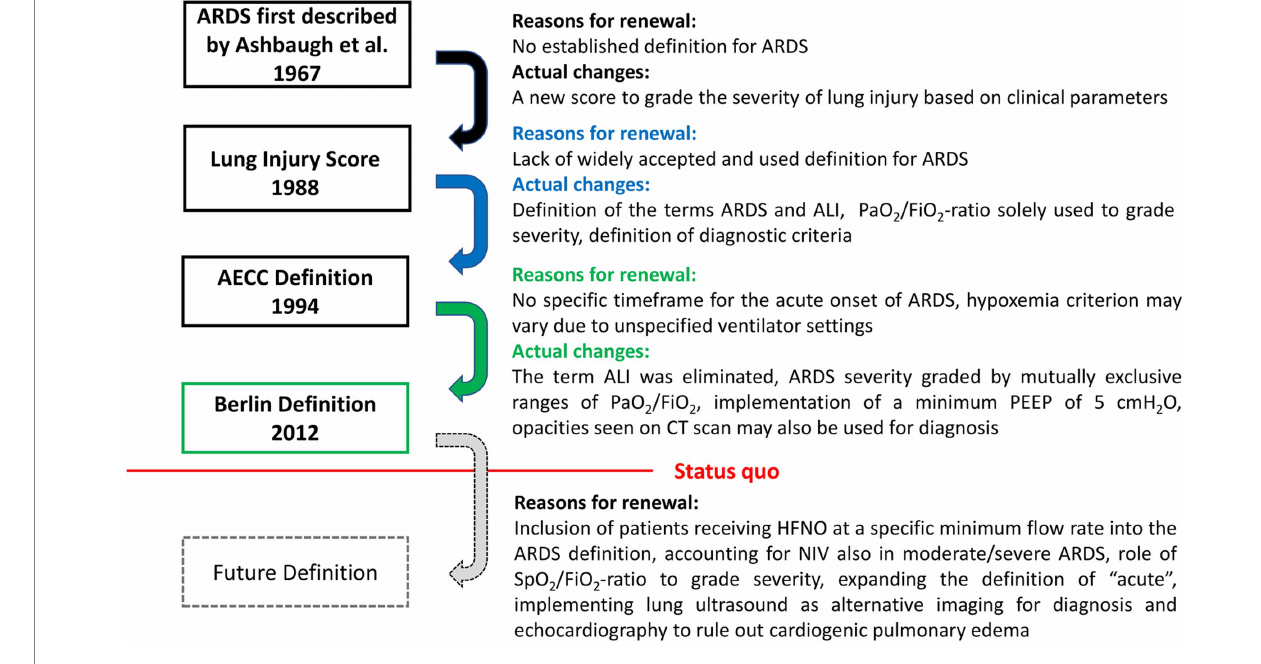
FIGURE 1 Questions arising in the development of ARDS definitions and future challenges. Multiple adaptations of the definition of acute respiratory distress syndrome (ARDS) have been implemented since its first description in 1967. Further changes leading to a new ARDS definition may arise from a growing body of evidence and constant evolution of clinical practice in acute respiratory failure. ALI, acute lung injury; PEEP, positive end-expiratory pressure; HFNO, high flow nasal oxygen therapy; NIV, non-invasive